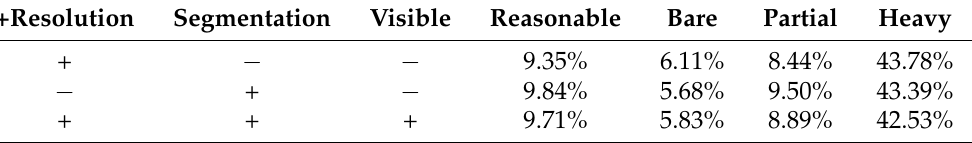
Table 2. Ablation study of different adding extra feature of segmentation and resolution and so